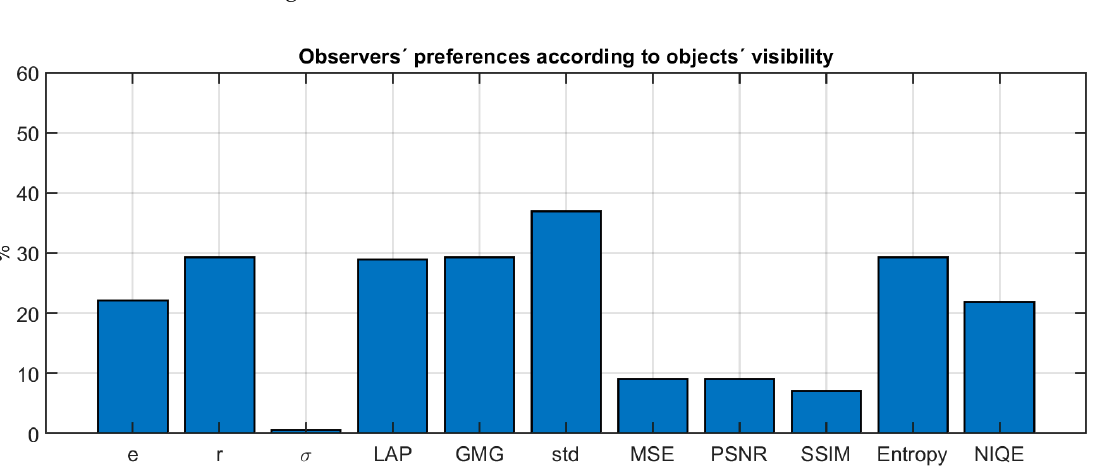
Figure 12. Percentage of agreement between the algorithm selected as best according to the observers’ answers to question 1 of the survey and the different metrics analyzed. We can see how now the similarity-based metrics (MSE, PSNR, SSIM) obtain higher levels of agreement with the observers than all others, except the e metric, which obtains even higher values than those shown in Figure 11. The level of agreement is in general lower than the one shown in